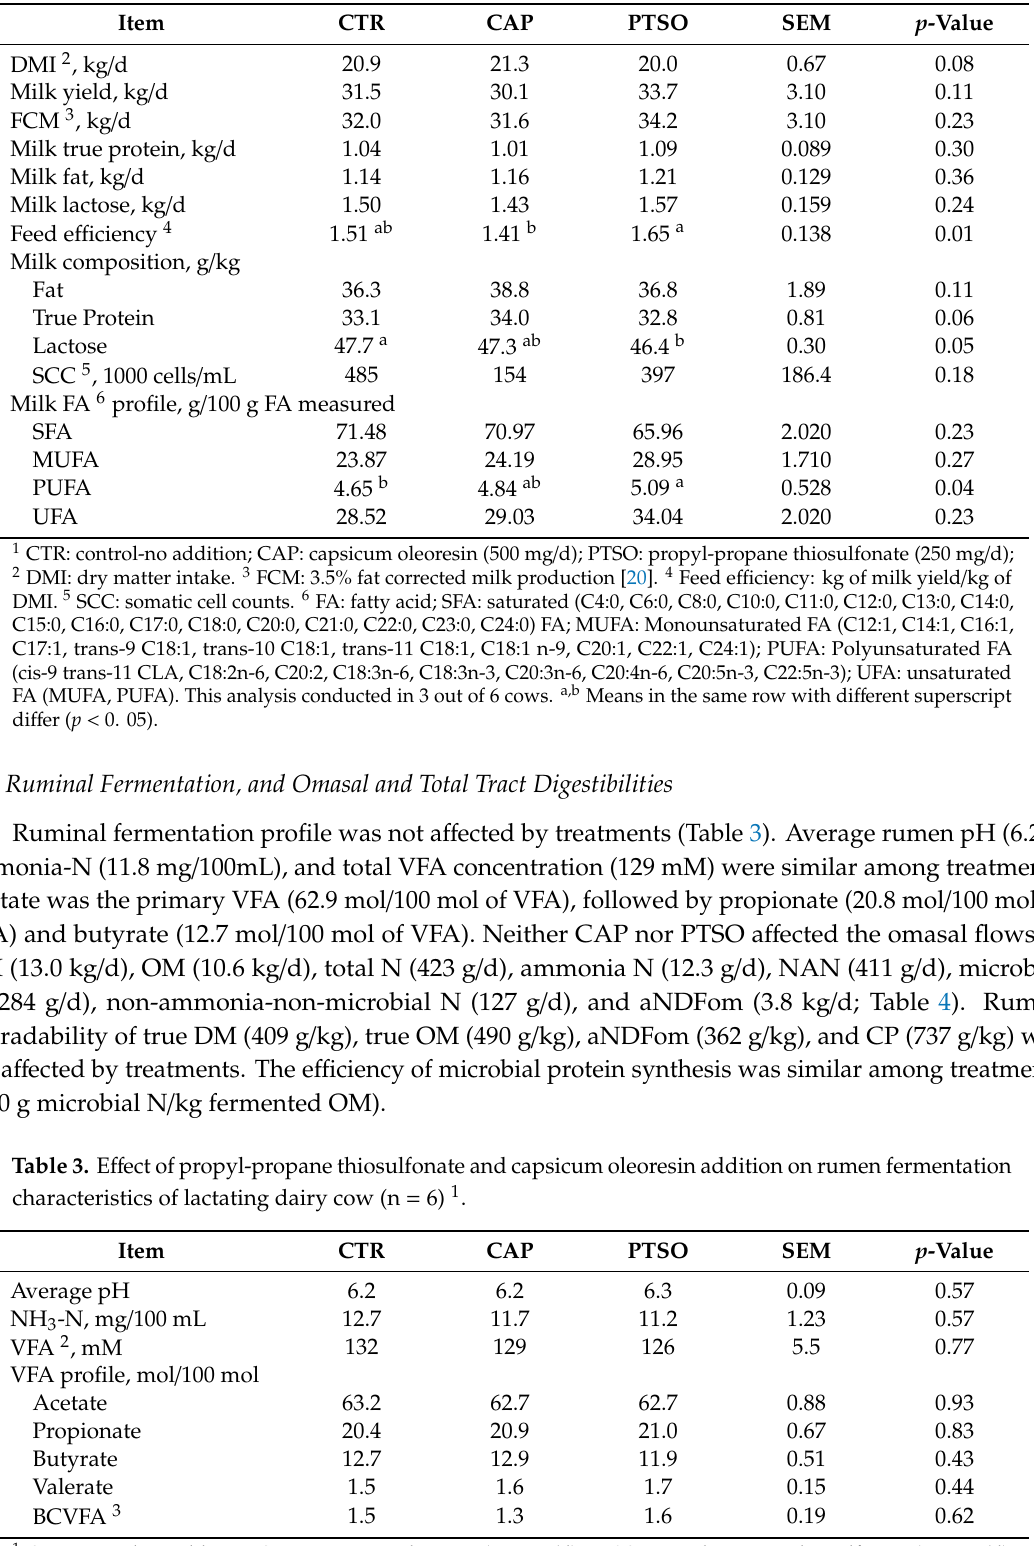
Table 2. E ff ect of propyl-propane thiosulfonate and capsicum oleoresin addition on dry matter intake, milk production, and milk composition of dairy cows (n = 6). 1